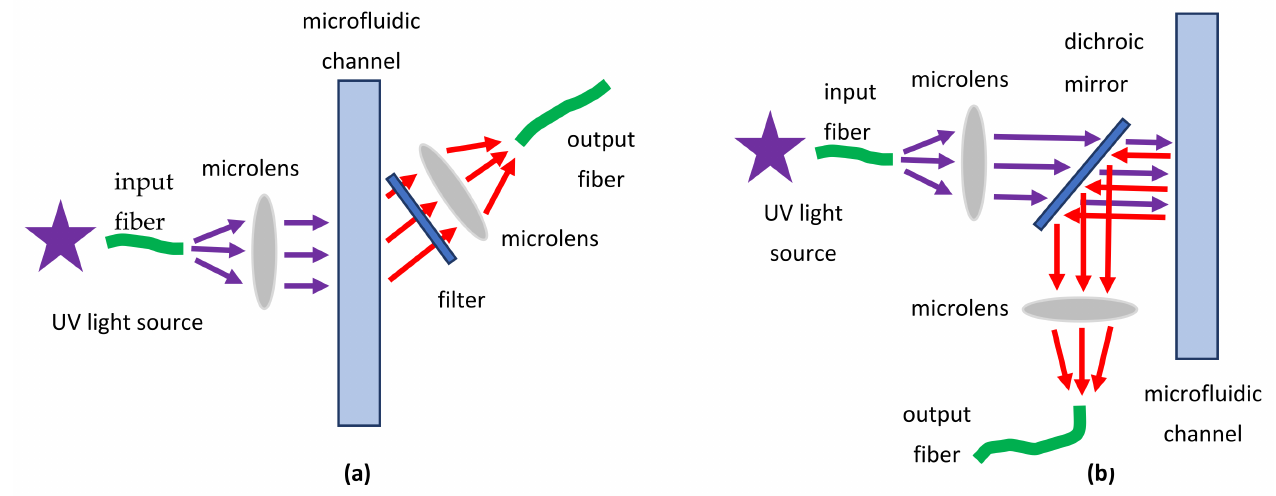
Figure 7. Proteinfluorescencedetection: orthogonal( a )andepifluorescence( b )setups(violetarrows—excitation optical radiation in the UV region, red arrows—fluorescence radiation in the visible or IR